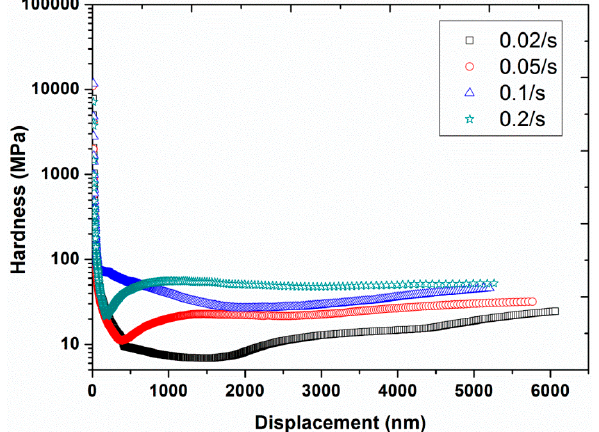
Figure 11. Hardness as a function of displacement for the four different strain rates (0.02, 0.05, 0.1, and 0.2 s − 1 ) at a frequency of 45 Hz and vibration amplitude of 2 nm.